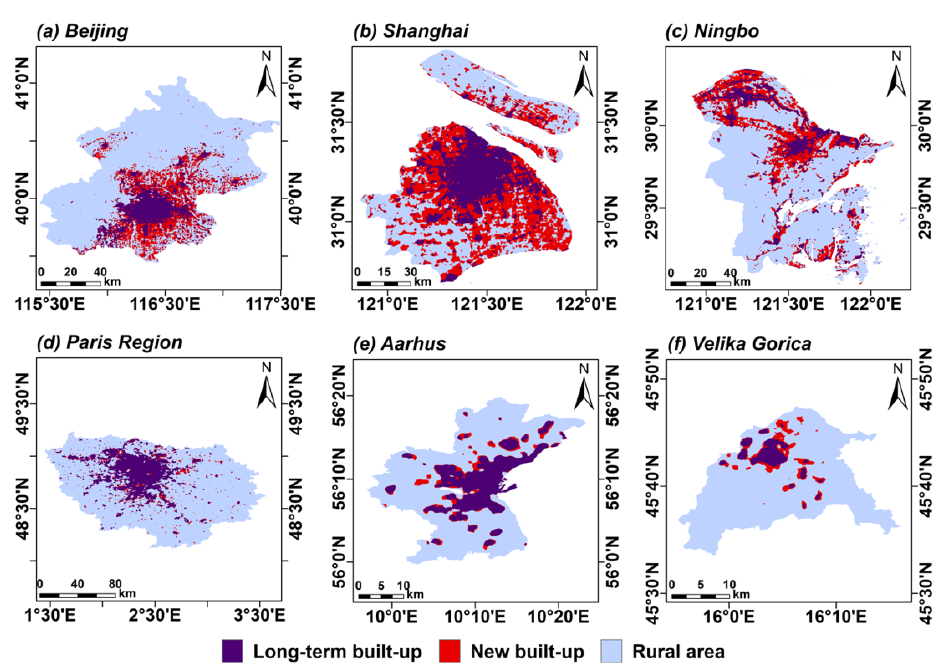
Figure A1. Urban-rural phases for all six cities in 2020.